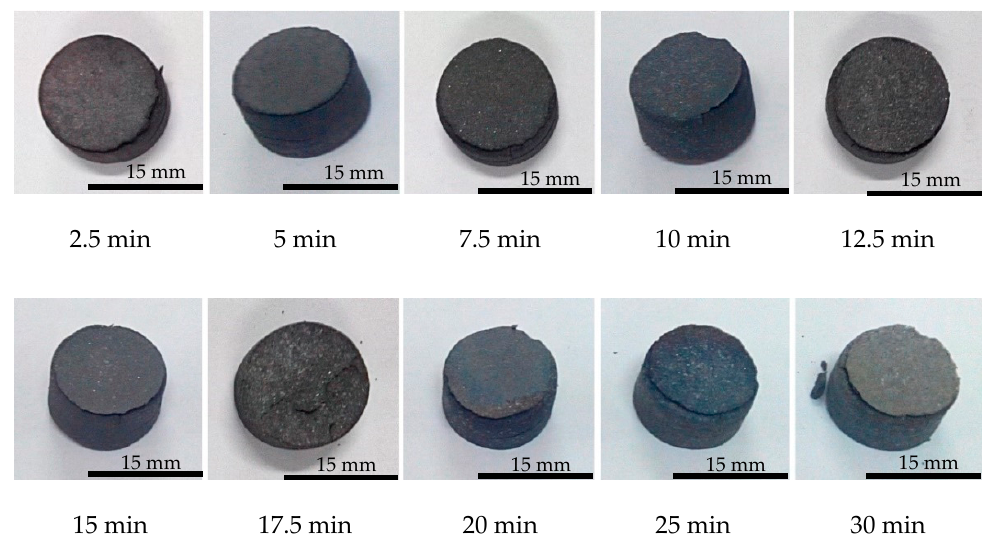
Figure 8. The macroscopic morphology changes of the reduced pellets at different times under vacuum condition. Table 4. The metallization ratio and dephosphorization ratio of